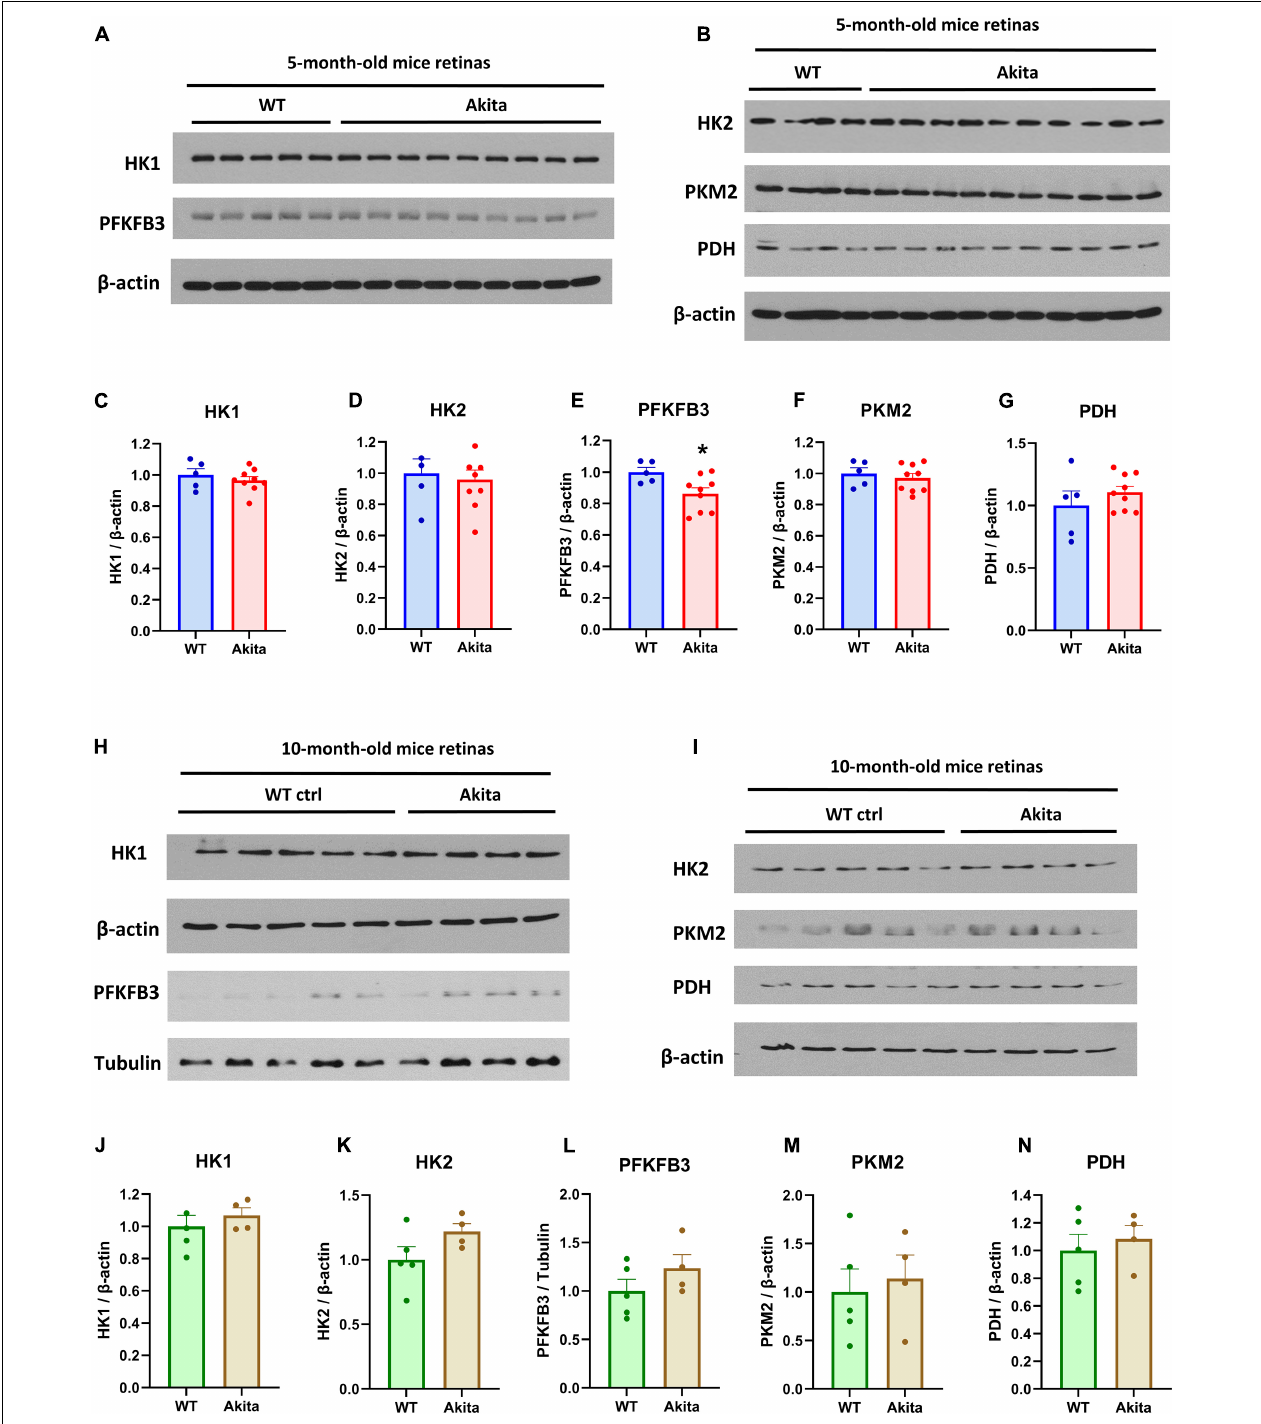
FIGURE 2 | Glycolysis enzymes expression in the Ins2 Akita diabetic retina. (A–G) Western blotting analyses and quantification was conducted for the glycolysis enzymes; hexokinase 1 (HK1), 6-phosphofructo-2-kinase/fructose-2,6-biphosphatase 3 (PFKFB3), hexokinase 2 (HK2), pyruvate kinase M2 (PKM2) and Pyruvate dehydrogenase (PDH). The expression of the rate limiting glycolysis enzyme, PFKFB3 shows a significant decrease in retinas from 5-month-old Akita mice while other key glycolytic enzymes remain unchanged. N = 5–9. * p < 0.05 vs. WT. Data is presented as fold change of the WT. (H–N) Western blotting analyses and quantification of the levels of the glycolytic enzymes mentioned above conducted on 10-month-old Akita mice retinas show no change in key glycolytic enzymes. N = 4–5. Data is presented as fold change of the WT.